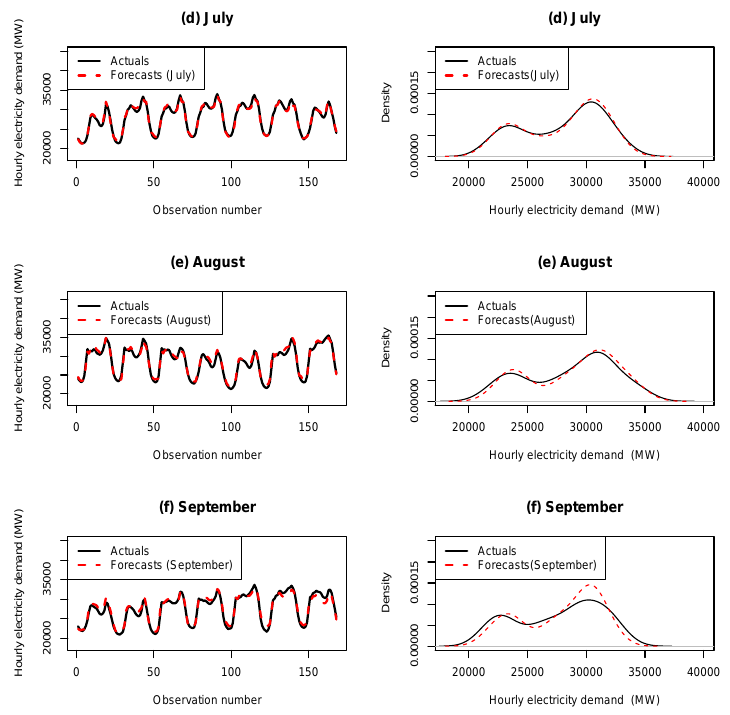
Figure A2. Hourly load superimposed with forecasts for the first 168 forecasts of each month of the months July to September 2012 together with their respective